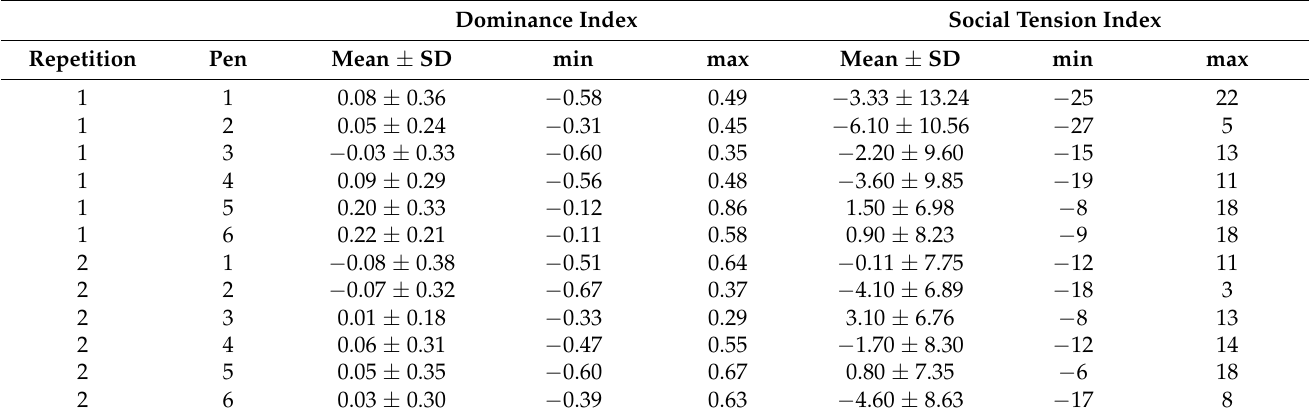
deviations. Highest mean dominance indices were found in pens 5 and 6 of repetition 1 whereas the mean social tension index was lowest in pen 2 of repetition 1 (Table 7). Table 7. Means ± SD and range of Dominance Index and Social Tension Index 1 per rearing pen and repetition.